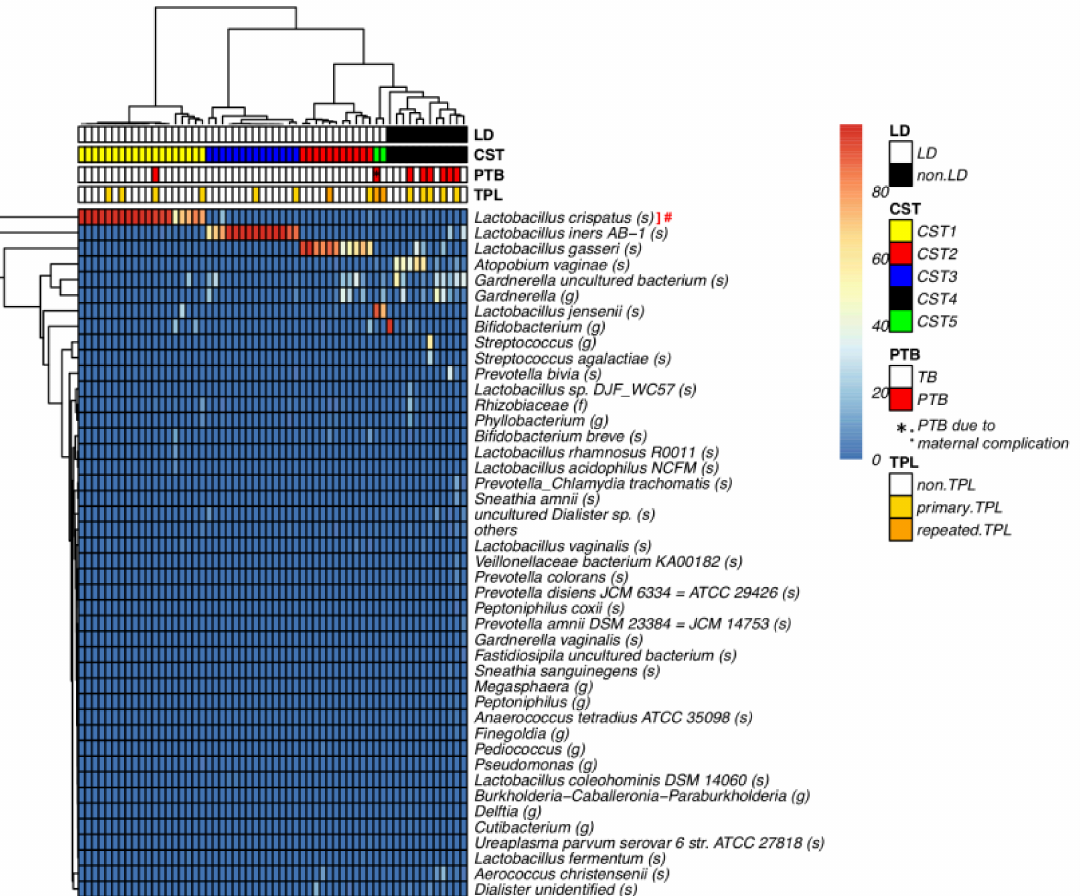
Figure 1. The vaginal microbiome was classified into five CSTs. Heatmap of microbial taxa found in the vaginal bacterial communities of 58 pregnant women (color key is indicated on the right bar). The taxon was defined as “others” when the maximum value of percentage was less than 1% in each vaginal sample. Ward’s method clustering of samples based on the species composition and abundance of vaginal bacterial communities that define community state types (CST) I to V on the lower bar, CSTI ( Lactobacillus crispatus , yellow), CSTII ( L. gasseri , red), CSTIII ( L. iners , blue), CSTIV (mixed anaerobes, black), CSTV ( L. jensenii , green). #: The ASVs of “ Lactobacillus (g)” and “ Lactobacillus_Chlamydia trachomatis (s)” were identified as genus of Lactobacillus crispatus by BLASTn. *: One PTB was due to maternal complication (* is shown in the small red square of PTB line at the upper part of the heat map). The raw data are available in Table